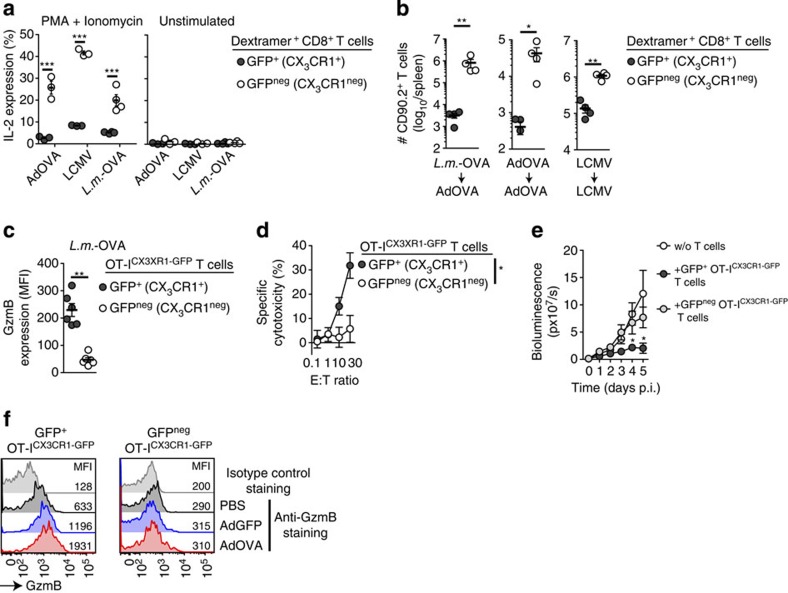
CX3CR1 expression separates memory CD8+ T cells with distinct functions.(a,b) CX3CR1+/GFP mice were infected with AdOVA (n=3), L.m.-OVA (n=4) or LCMV WE (n=3). At 45–60 d.p.i., spleen-derived GFP+ (CX3CR1+) and GFPneg (CX3CR1neg) memory T cells specific for OVA (after AdOVA and L.m.-OVA infection) or for LCMV gp33 were obtained by FACSorting. (a) Ex vivo IL-2 production after stimulation with PMA/ionomycin. ***P<0.001, unpaired t-test. (b) Adoptive transfer of sorted OVA-specific or LCMV-specific CD8+ T cells (2 × 103) into CD90.1+ mice (n=4) subsequently infected with AdOVA or LCMV. Determination of CD90.2+ T-cell numbers at 8 d.p.i. in the spleen. *P<0.05 and **P<0.01, unpaired t-test. (c–e) Adoptive transfer of FACSsorted naive CD45.1+CD44low OT-ICX3CR1-GFP T cells (5 × 102) into CD45.2+ mice followed by L.m.-OVA infection. (c) At 45–60 d.p.i, CD45.1+ Memory OT-ICX3CR1-GFP T cells from the spleen were analysed for intracellular GzmB expression (n=6). **P<0.01, unpaired t-test. (d) OVA-specific cytotoxicity of sorted GFP+ and GFPneg memory OT-ICX3CR1-GFP T cells directly ex vivo. *P<0.05, ANOVA. (e) Adoptive transfer of 3 × 105 sorted GFP+ or GFPneg memory OT-ICX3CR1-GFP T cells into mice (n=6) that were infected with AdOVALUC 4 h before. In vivo bioluminescence activity was determined to measure T-cell effector function against virus-infected luciferase-expressing hepatocytes over time. AdOVALUC-infected mice that did not receive T cells served as controls (n=6). Data are representative for —two or three independent experiments. *P<0.05, two-way ANOVA. (f) Challenge of mice harbouring CD45.1+ Memory OT-ICX3CR1-GFP T cells with AdGFP or AdOVA and 6 h later determination of GzmB expression in splenic GFP+ and GFPneg memory OT-ICX3CR1-GFP T cells. Data are representative for two independent experiments (a,b,d,e, mean and s.d.) or have been pooled from two independent experiments (c,f, mean and s.e.m.). In scatter plots of a–c, each dot represents data from one mouse. Fluorescence-activated cell sorting plots shown in d are representative for one mouse of a group of three or four mice per experiment.